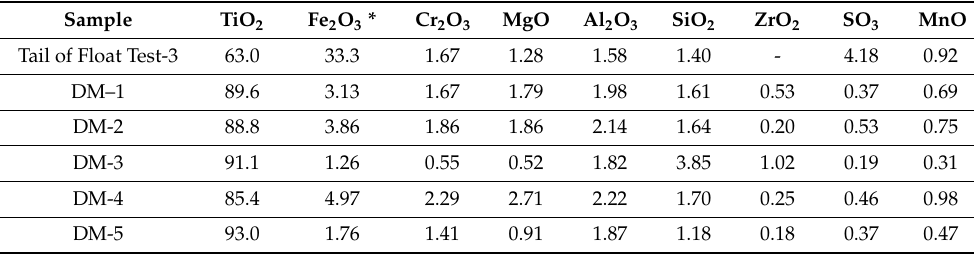
Table 5. XRF analysis results from sample DM-1 to DM-5 (%wt.). The table also includes the data for the sample before demetallisation (Flotation Test-3 Tail) for comparison. Sample